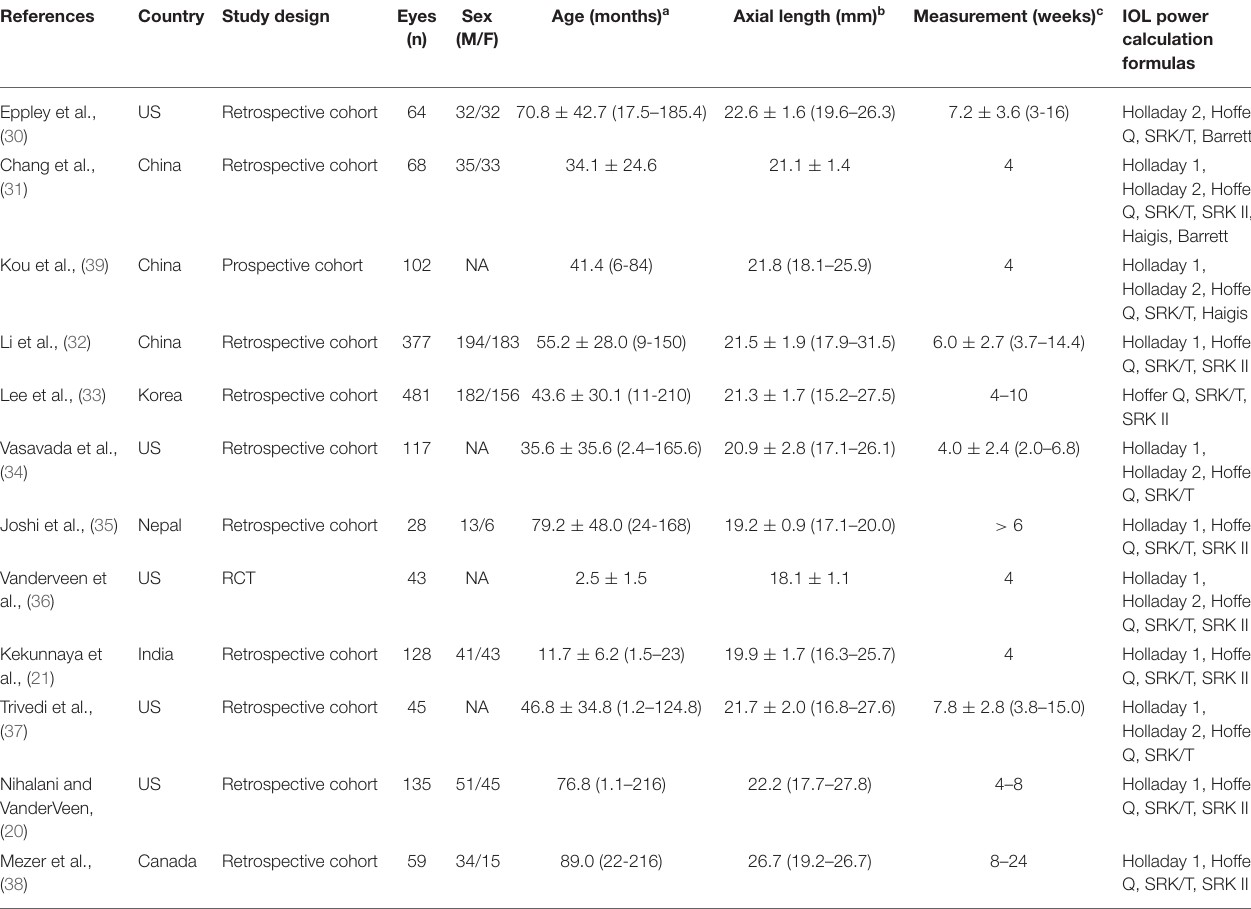
TABLE 1 | Characteristics of the included studies ( n =